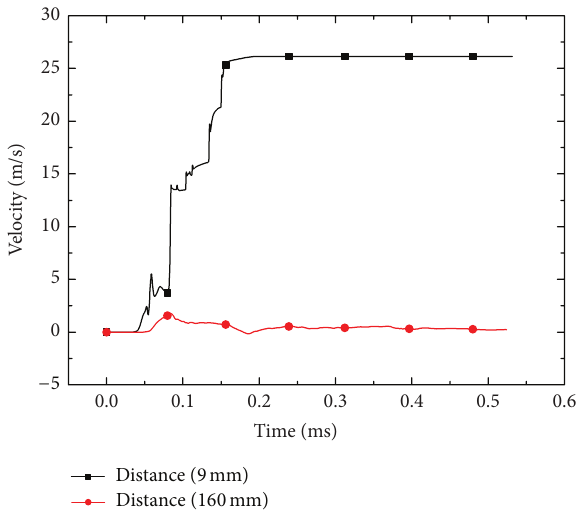
Figure 9: Ejection velocity versus time at typical target on the free surface.